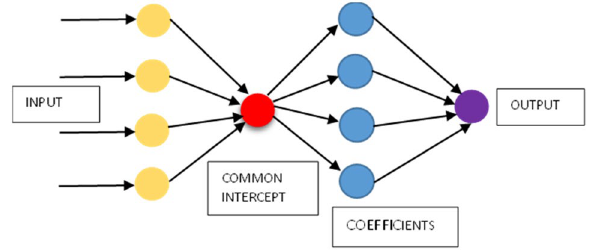
Fig. 2 Typical architecture of MLR